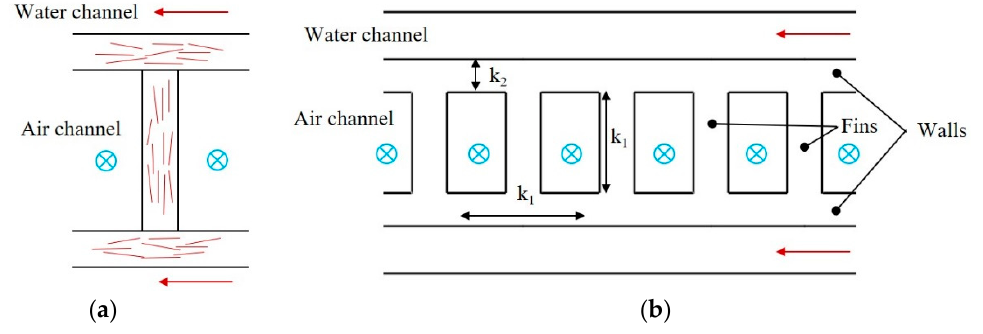
Figure 12. ( a ) Illustration of a fin between two walls showing the fiber orientation. ( b ) Cross-section of plate fin geometry with anisotropic conductivity orientations k 1 (aligned with fibers) and k 2 (perpendicular to fibers).